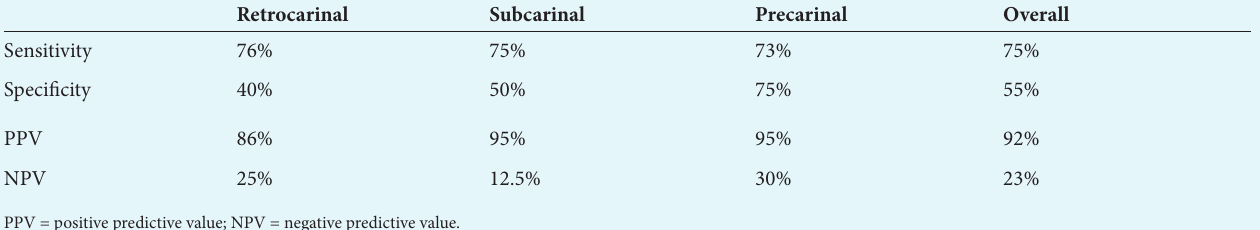
Table 3. Sensitivity, specificity, PPV and NPV of lateral CXR for presence of lymphadenopathy when compared with sagittal CT reconstructions by zone